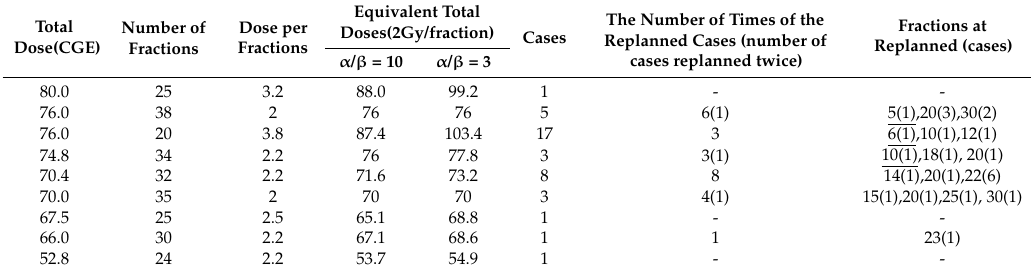
Table 2. Treatment protocols.